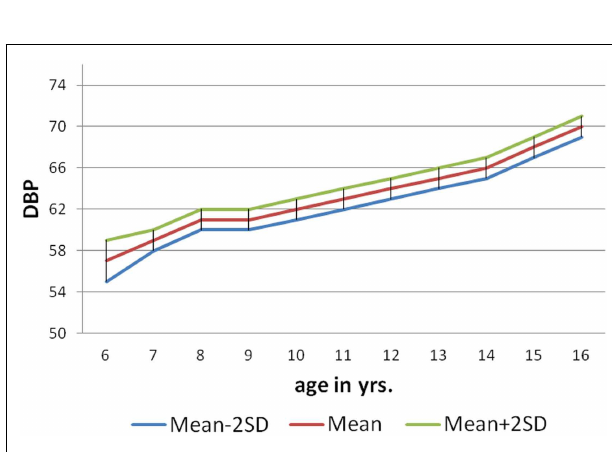
FIGURE 4 | Norms of mean DBP according to age in girls (6–16years)